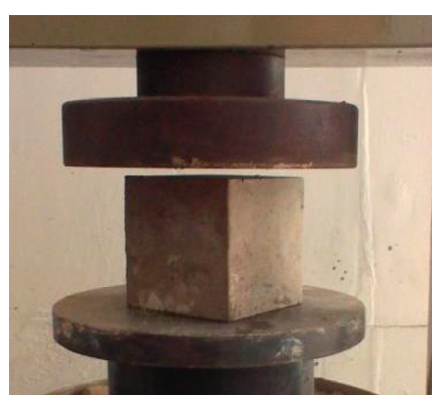
Figure 6: The test of compressive strength.